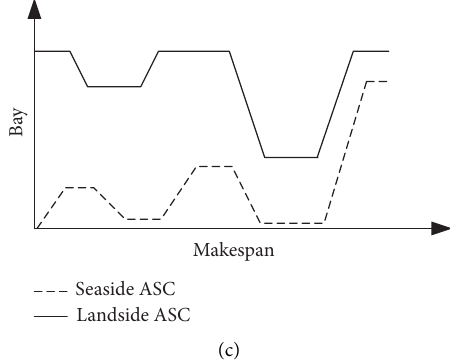
Figure 3: ASC operation conflict and handling